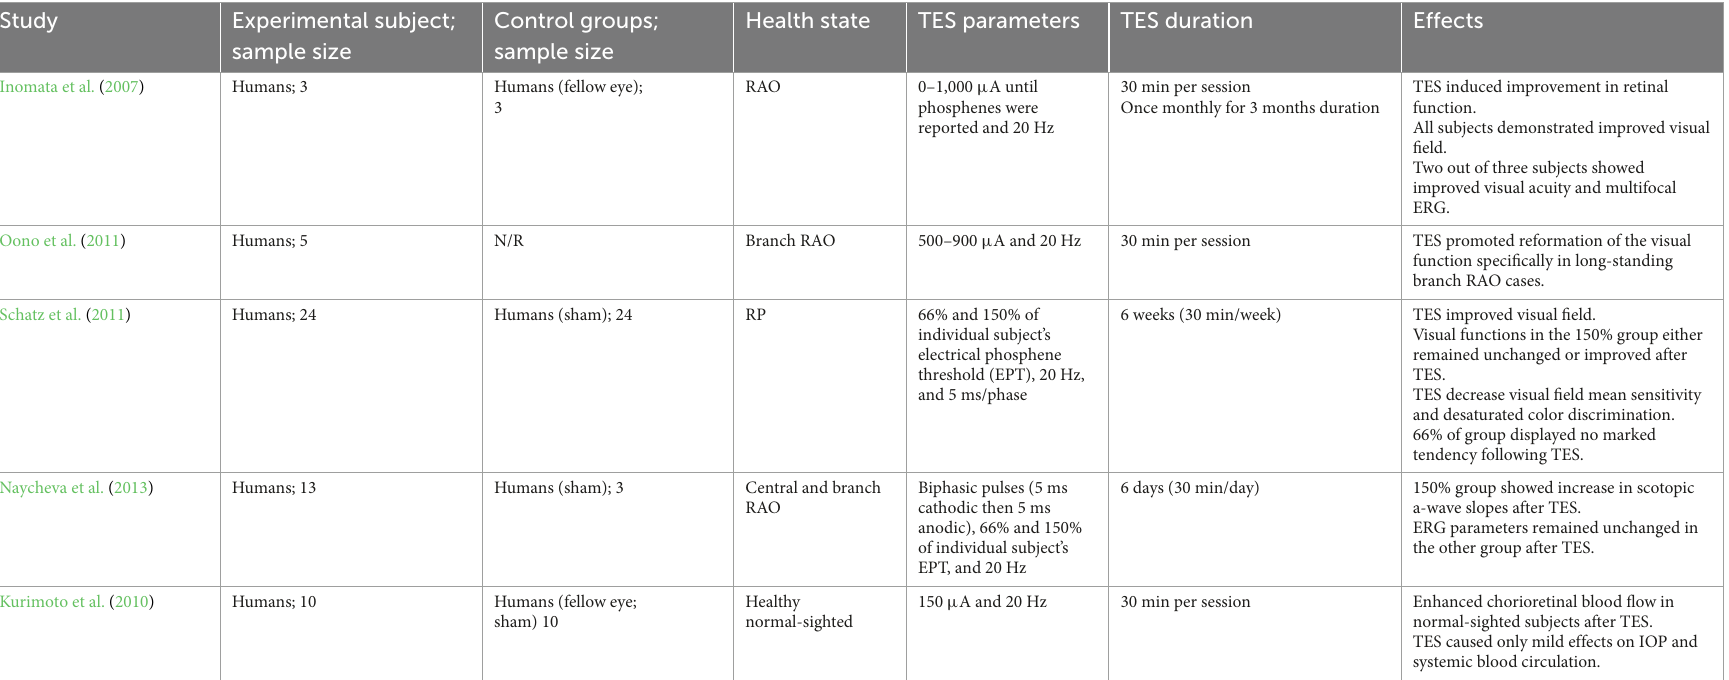
TABLE 2 Summary of clinical studies on TES effects in the